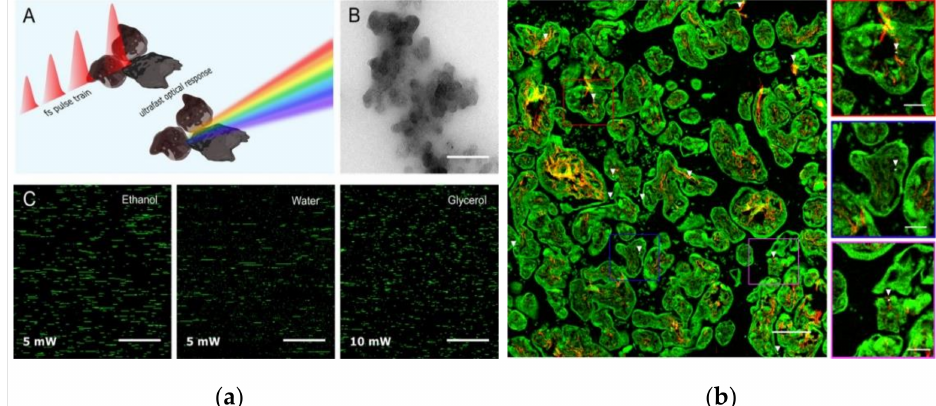
Figure 6. ( a ) The detection method of CB NPs based on WL emission: ( A ) Schematic showing the emission and excitation process. ( B ) TEM image of CB NP aggregates. Scale bar: 300 nm (CB). ( C ) CB detection using the FPLM detection method in different sampling conditions.